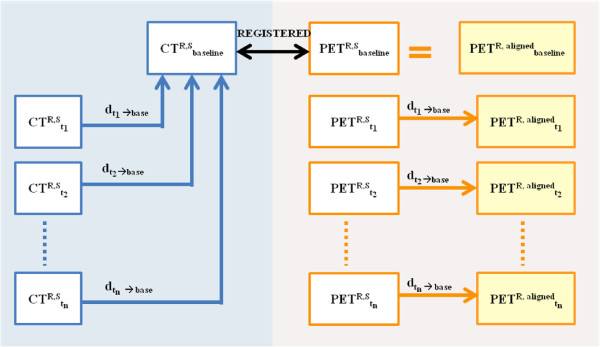
Scenario of our proposed registration framework. In the first step (left) for each animal ‘R’, we registered segmented CT volumes (CT R,S) from different time points (tn) to a baseline scan and stored the deformation fields
(dtn→base). Since the PET images are co-registered with these CT scans, we applied the corresponding deformation field to the segmented PET scan (PET R,S) in order to align the PET radiotracer regions over time (PET R, aligned)(right). This process allowed visualization of changes in active PET lesions throughout the imaging study.